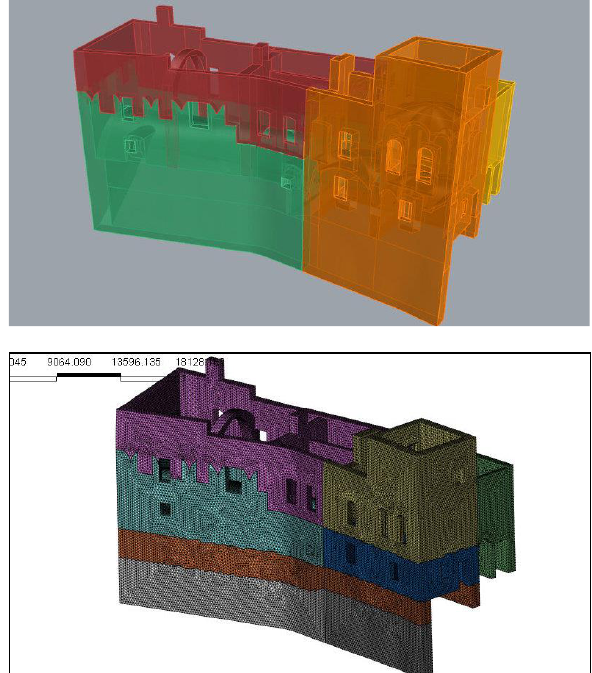
Fig. 6. The BIM turned into a finite element model following construction stages and material